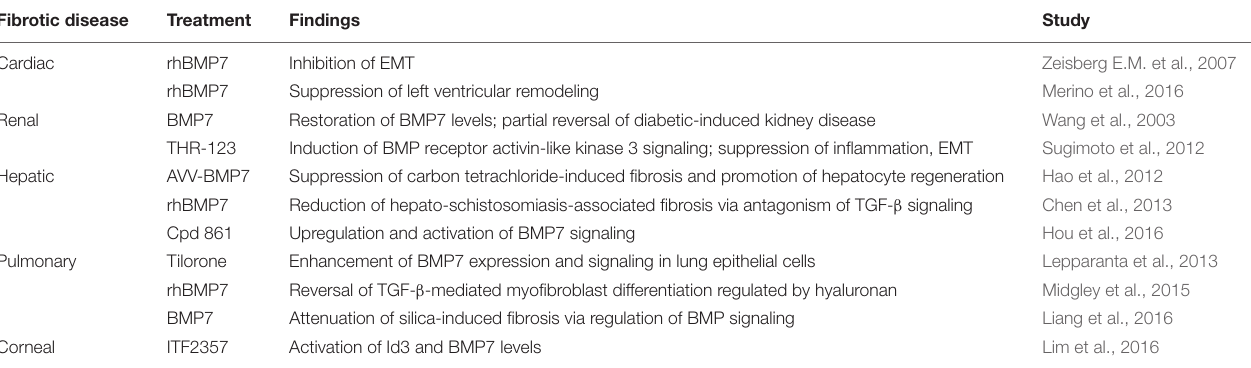
TABLE 1 | Antifibrotic therapeutic potential of targeting BMP7